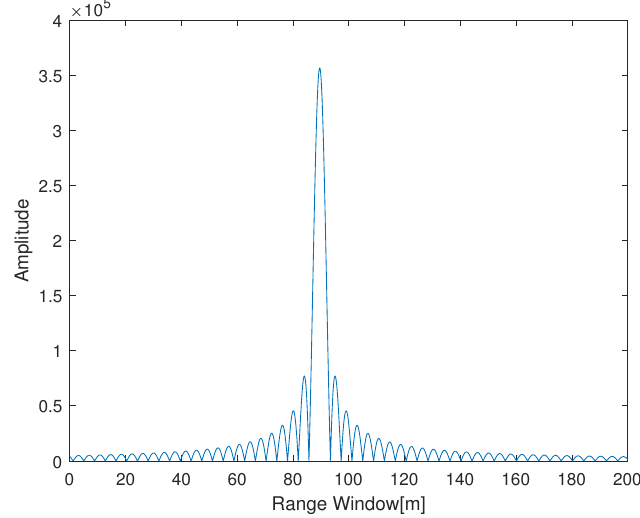
Figure 4. PCSNR at an ideal VPA parameter.